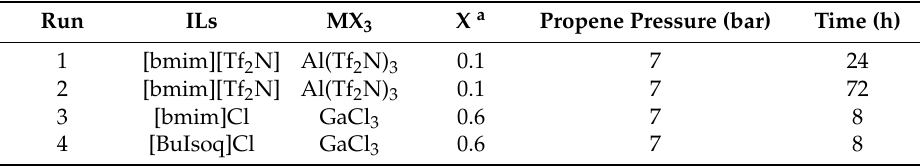
Table 1. Reactions of methyl linoleate with propene under pressure at 100 ˝ C.